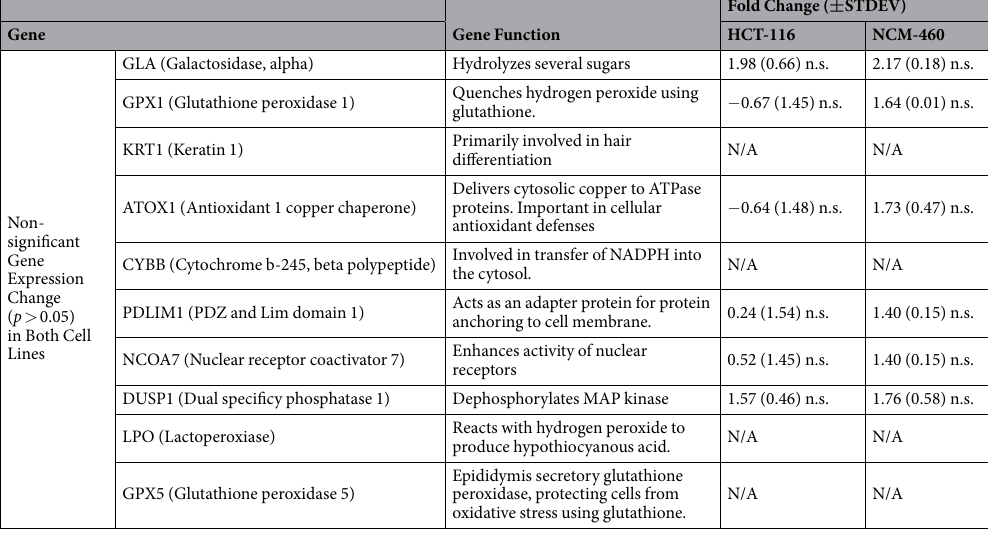
Table 8. Summary of the Relative-Fold Change in Gene Expression Utilizing RT 2 PCR. Statistical analysis was performed using One-Way ANOVA to relative-fold change of the control (1). * p < 0.05 vs control; ** p < 0.01 vs control; *** p < 0.001 vs control; **** p < 0.0001 vs control. n.s. = not significant, p > 0.05 vs control. N/A = not applicable due to no amplification detected. Gene function was obtained searching the UniProt or NCBI Gene